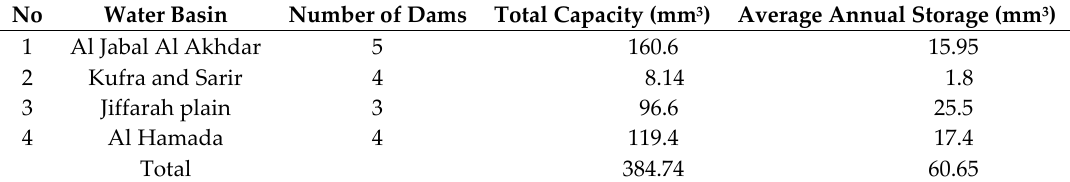
Table 1. Constructed dams in Libya.